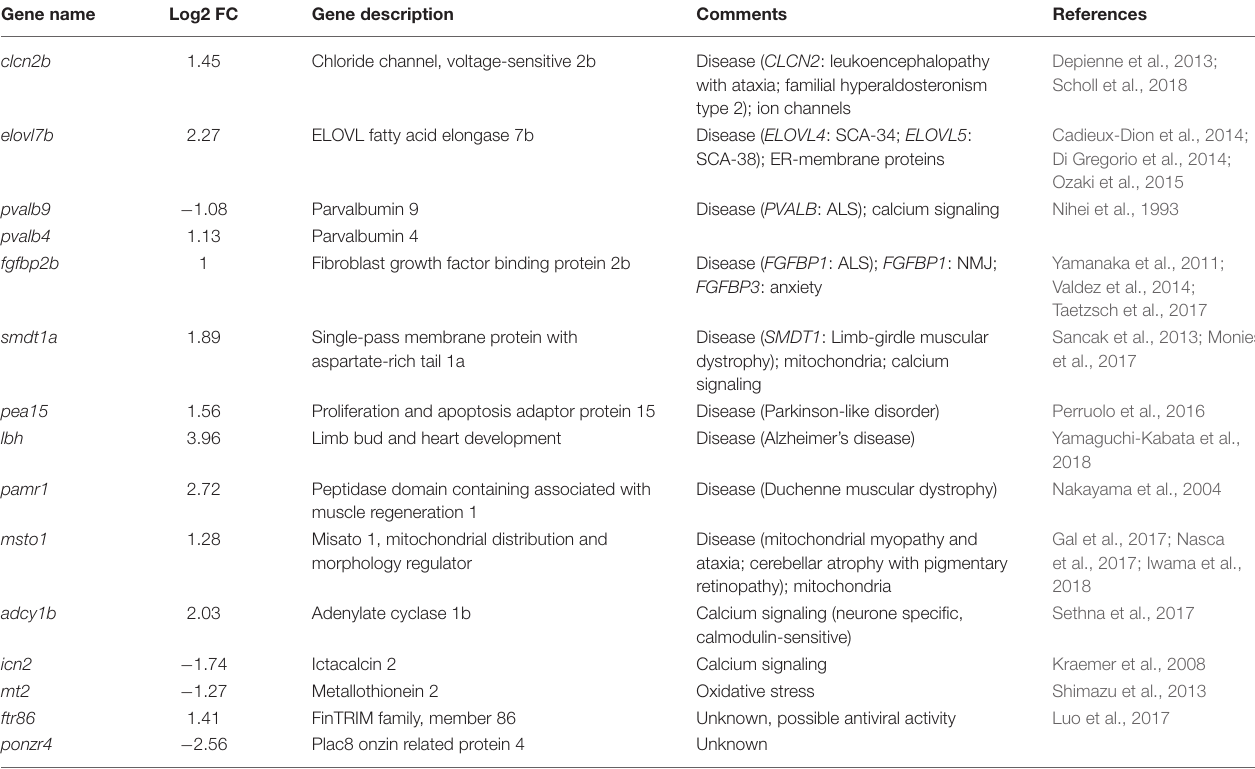
TABLE 1 | Genes of interest from the RNA-sequencing